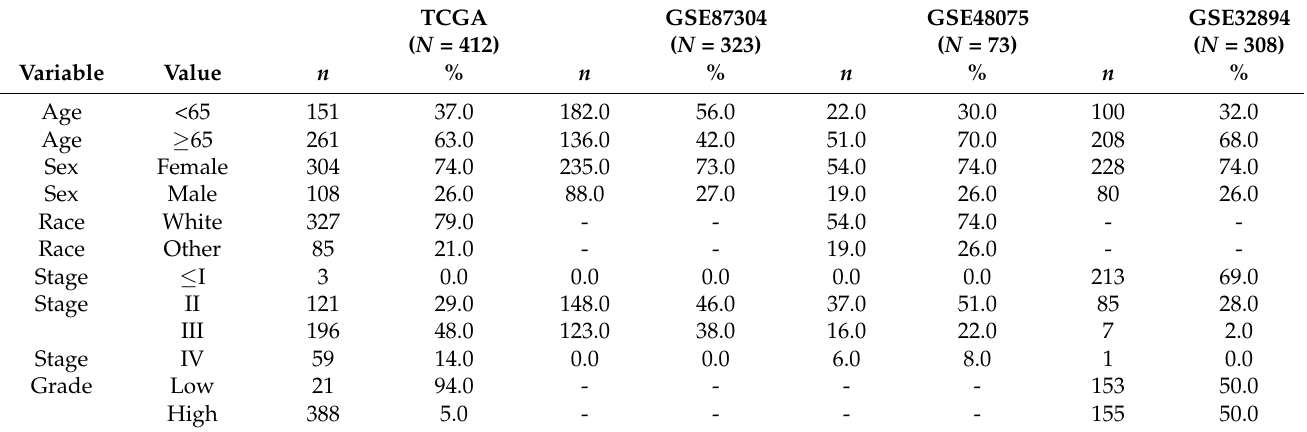
Table 1. Demographic and clinical-pathologic characteristics of study